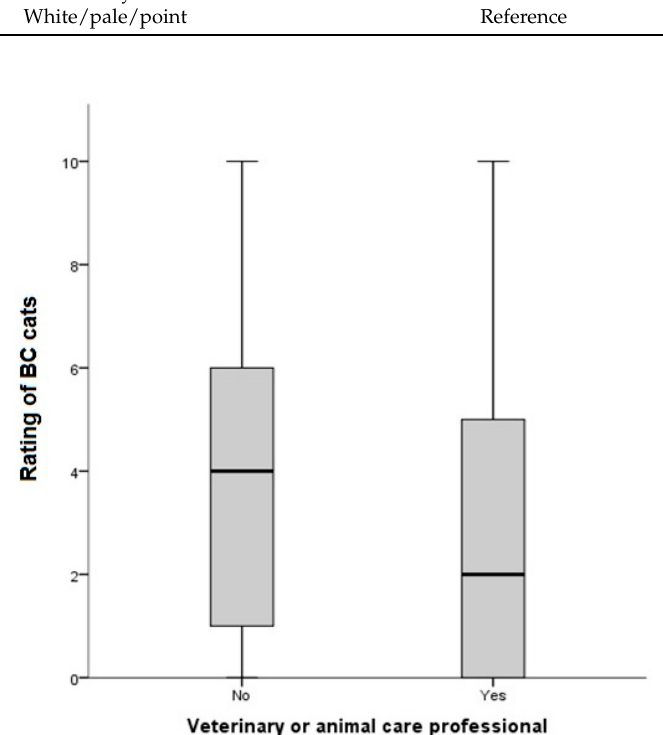
Figure 2. Significant differences (KW = 277.9, df = 2, p < 0.001) in ratings of brachycephalic (BC) cat images ( n = 7/15; as per Table 1) between respondents that identified as veterinary or animal care professionals ( n = 244) as opposed to those that did not ( n = 995).